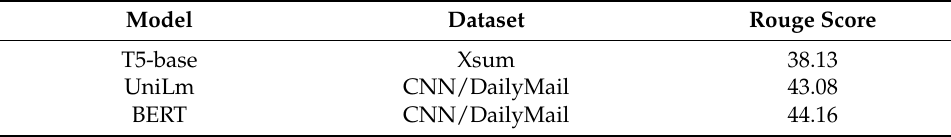
Table 6. Performance evaluation (model